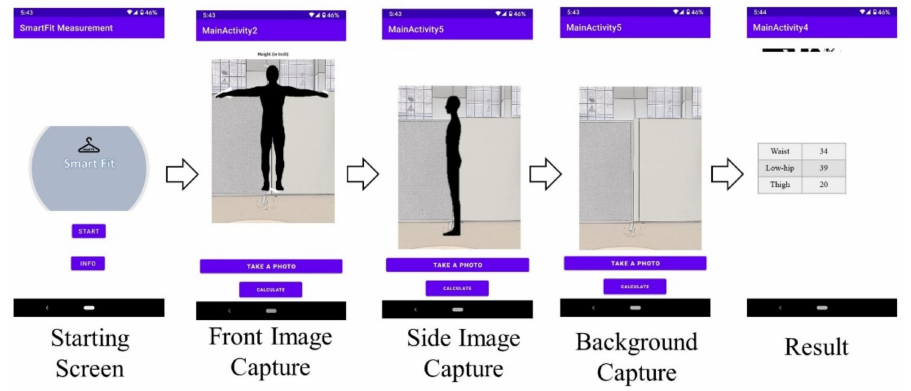
Figure 12. Steps for using the SmartFit Measurement application.